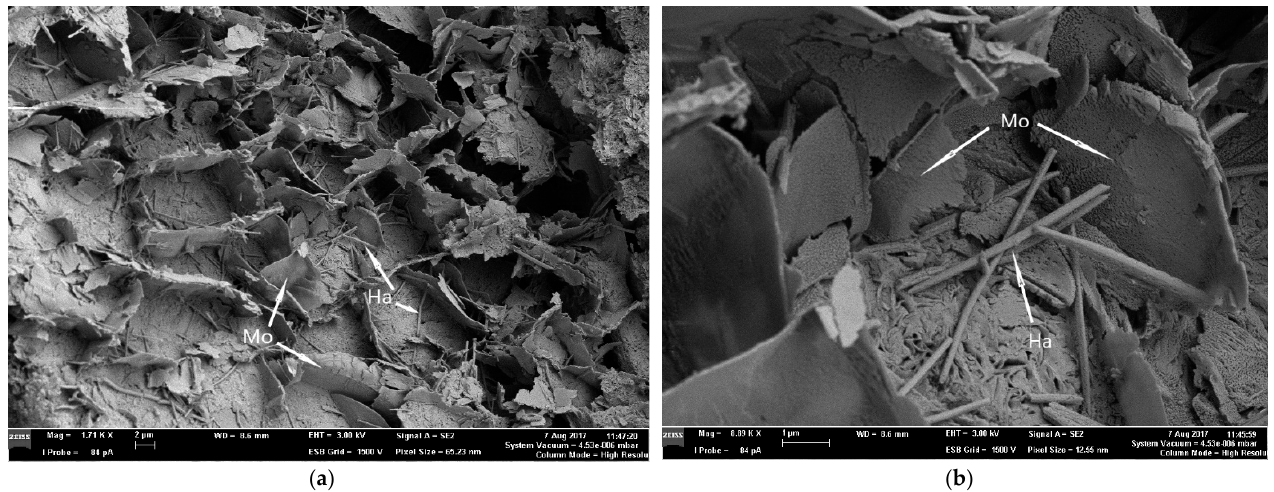
Figure 4. SEM micrograph of a freshly broken sample of bentonite from the white Ora ș u Nou; ( a ) massive montmorillonite flakes (Mo) and halloysite nanotubes (Ha); ( b ) detail with montmorillonite flakes (Mo) and halloysite nanotubes (Ha).